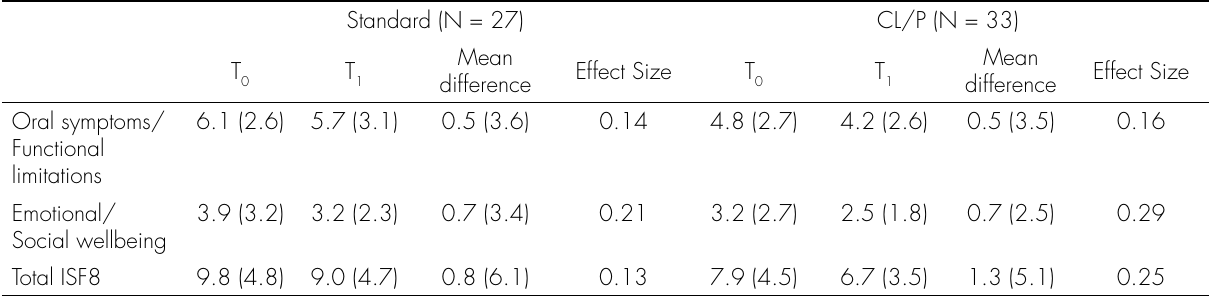
Table III. Mean baseline, post-treatment and changes in CPQ-ISF8 domains by study group (brackets contain percentages unless otherwise stated).